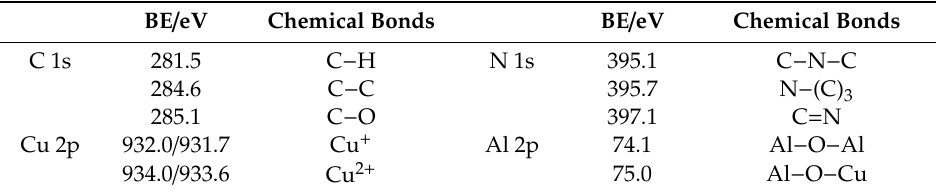
Table 1. XPS results of the Cu / Al 2 O 3 / CN composite.